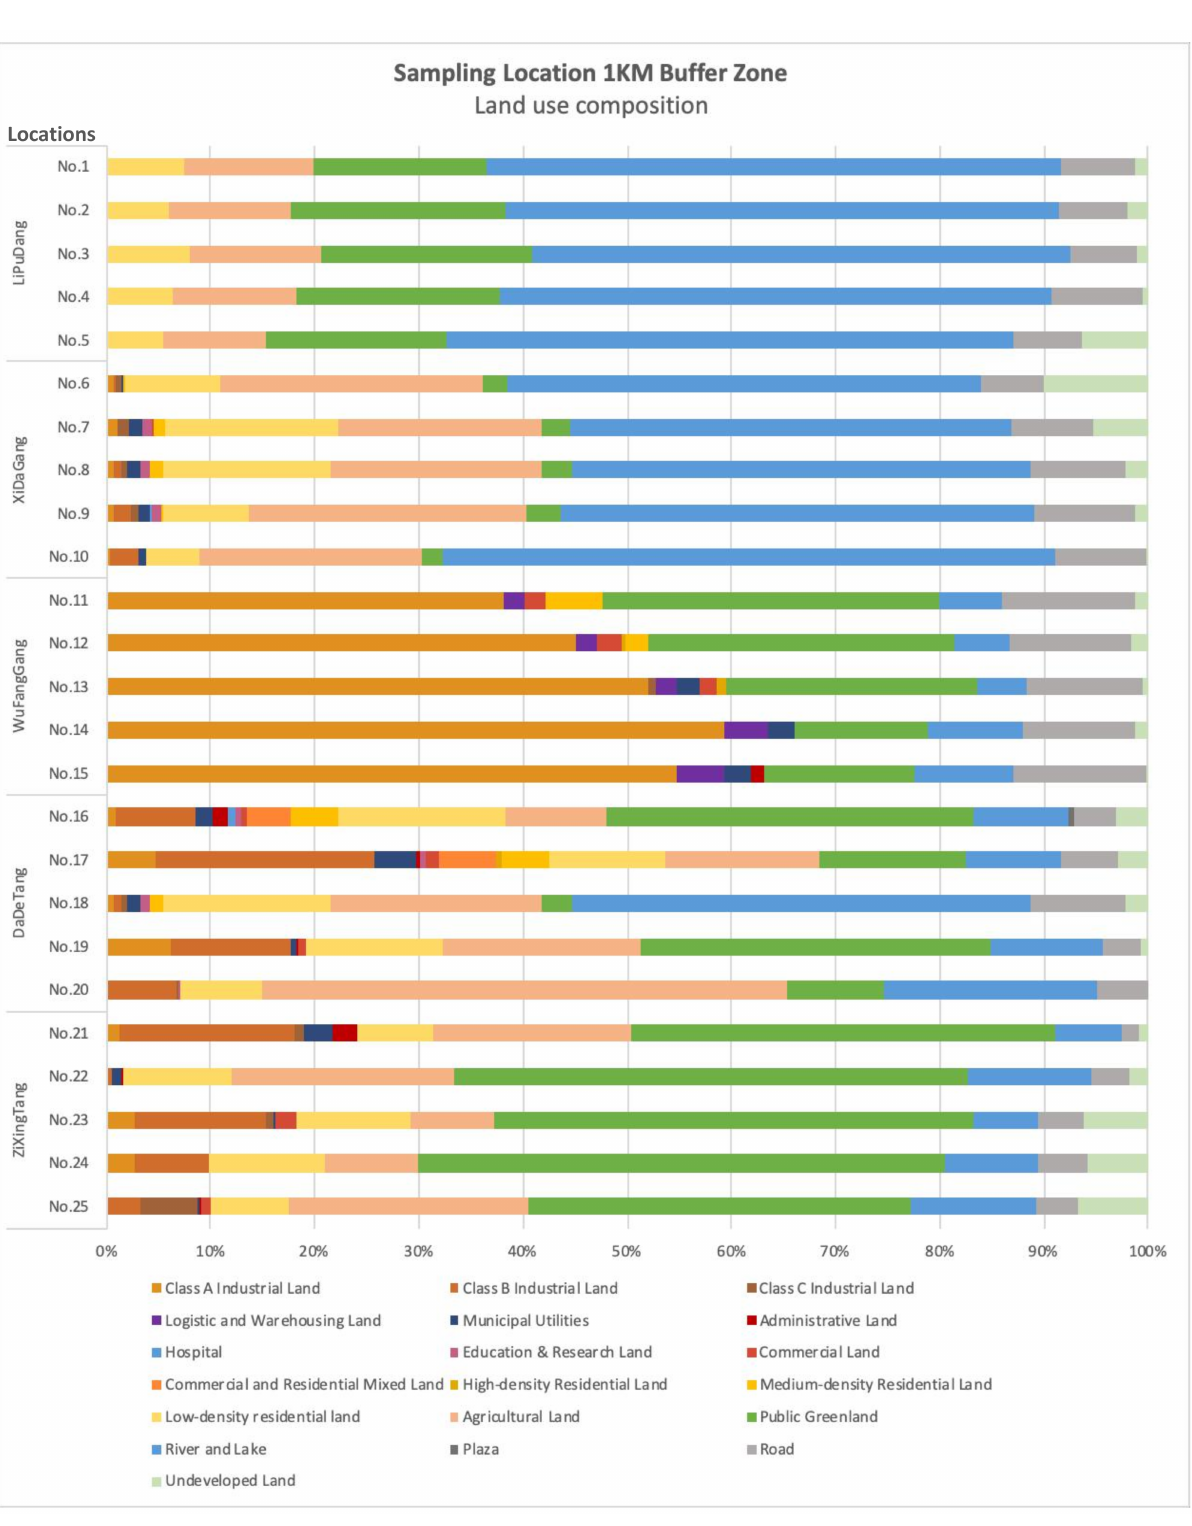
Figure 7. Land use pattern of 1 Km buffer zone around 25 sampling locations. Different colors indicate corresponding land use classifications. Location number 1–5, LPD lake; 6–10, XDG river; 11–15, WFG river; 16–20, DDT river; 21–25, ZXT